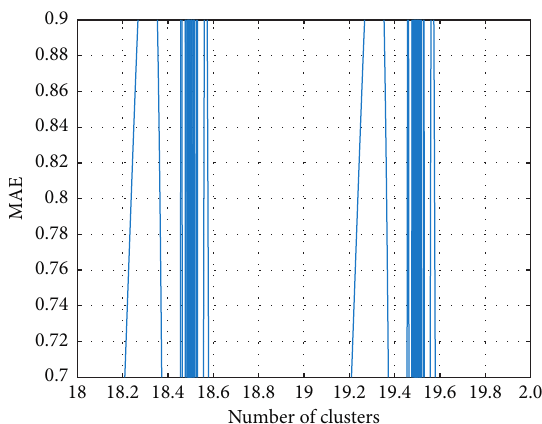
Figure 5: Comparison of recommended performance of different cluster